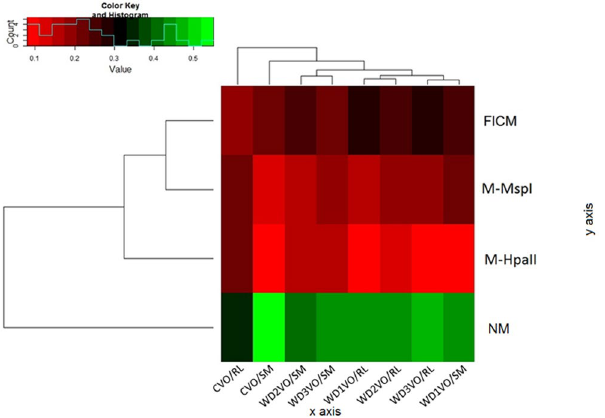
Figure 4. Heatmap representation ofthe methylation profile obtained with MSAP analysis digested with the MspI and HpaII enzymes to evaluate the VO/RL and VO/SM genotypes and the treatments (Control-C, and the different WD1, WD2 and WD3 deficit levels) in which NM characterizes the presence of bands cut with both enzymes and that there was non-methylation; M-HpaII presence of methylation from the cut with HpaII; M-MspI presence of methylation from the cut with MspI; and FICM identifies the group of bands in which there are no cuts where there are different types of full or internal methylation of methyl cytosine and/or